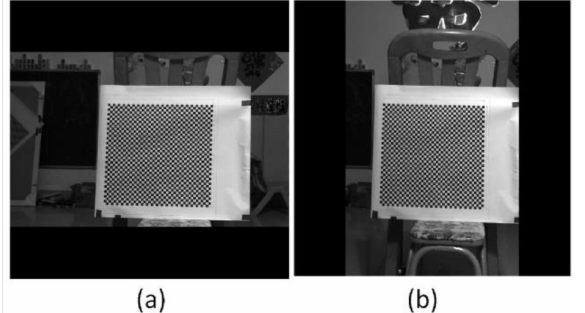
Figure 11. Anamorphic images after anamorphic ratio ( AR ) rectification. ( a ) Rectified image when the anamorphic lens was in the vertical position, and ( b ) rectified image when the anamorphic lens was in the horizontal